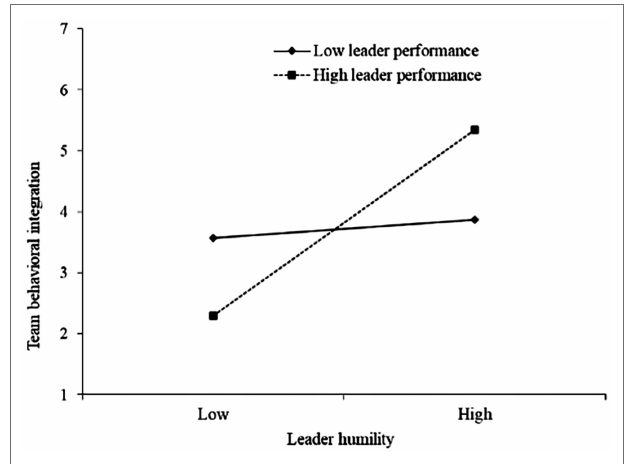
FIGURE 2 | The interaction effect between leader humility and leader performance on team behavioral